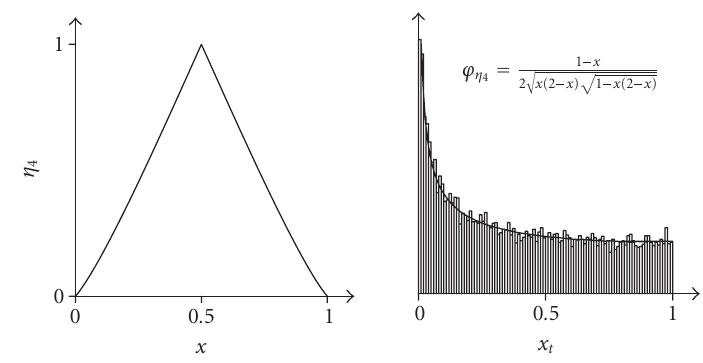
Figure 4.1. Illustration of Example